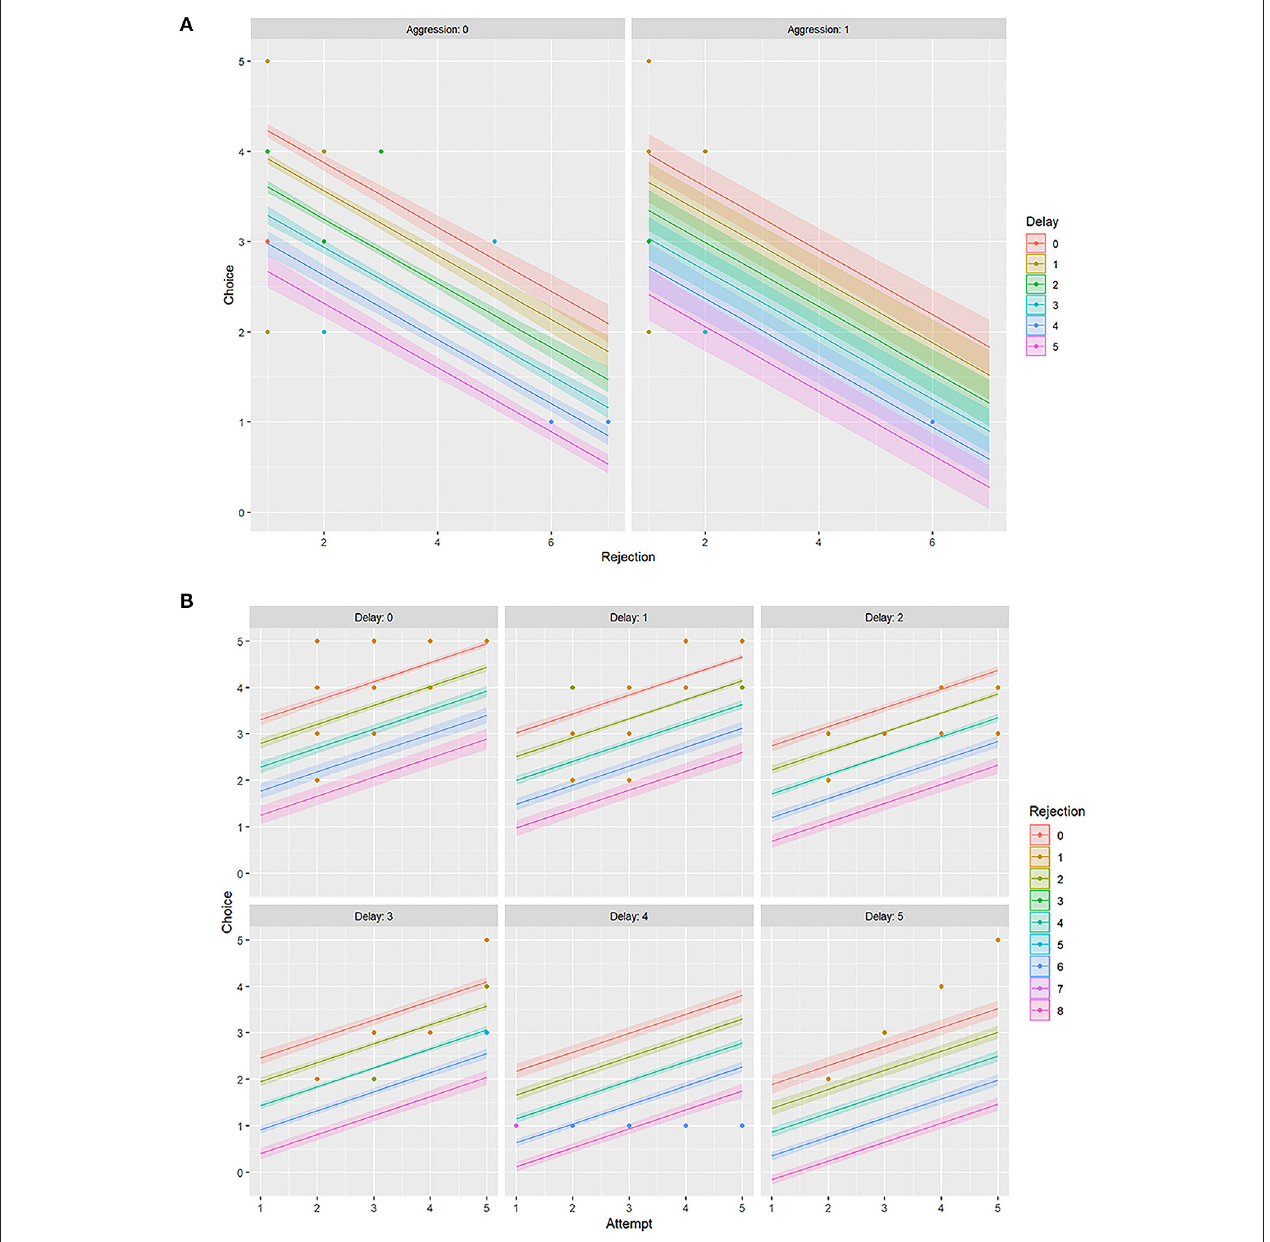
FIGURE 6 | Linear model (LM) plot representing the variations in the choice of food for “rejection” and “delay.” The width of the color bands increases with the delay. (A) LM plots showing different levels of “aggression” has different effects on food choice. The left panel represents data for “zero aggression,” whereas the right panel shows that the “presence of aggression” increases the delay in food choice. (B) LM plots showing the effects of “attempt” on food choice, together with “delay” and “rejection.” Each panel represents a particular “delay” score. For example, the top left panel is for “no delay” or “zero” delay score, and the bottom right is for the “maximum delay” i.e., score